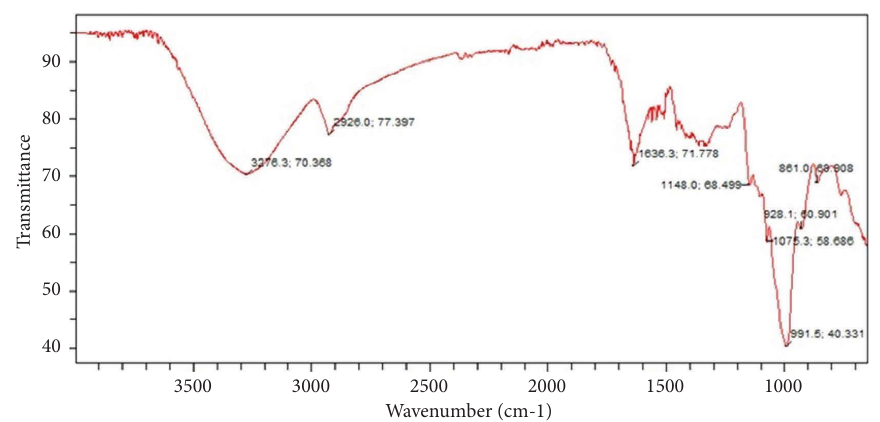
Figure 3: Representative FTIR spectrum of Zingiber ofcinale